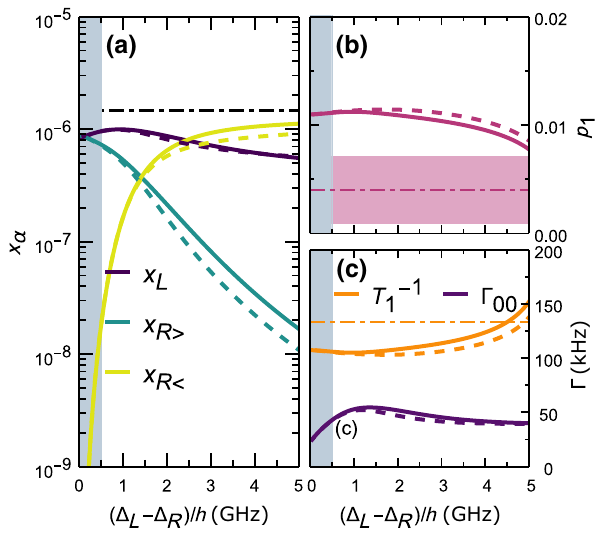
FIG. 5. The steady state for the quasiparticle-qubit system as a function of the gap difference ((cid:2) L − (cid:2) R )/ h in the modeling of the experiment of Ref. [35], the results of which are repre- sented by the horizontal dot-dashed lines. (a) The quasiparticle densities in the steady state. (b) The population of the excited state of the qubit in the steady state. (c) The qubit inverse relax- ation time and parity-switching rates in the steady state. The dashed curves are given by Eqs. (21)–(23) for (a), Eq. (24) for (b), and Eqs. (10) and (25) for (c). Parameters: (cid:2) L / h = 52 GHz, /( 2 π) = 5.7 GHz, E / h = 15.5 GHz, E / h = 290 MHz, ω 10 J C T qp = 20 mK, ν 0 = 0.73 × 10 47 J − 1 m − 3 , V L = V R = 940 μ m 3 , r L = r R < = ( 160 ns ) − 1 , (cid:12) ph = 1 kHz, and (cid:12) ex = ( 16 μ s ) − 1